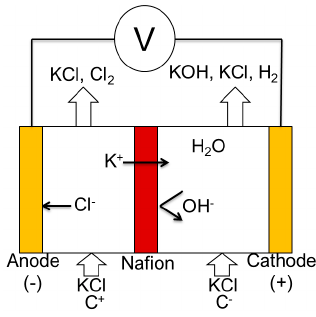
Figure 6. Ionic exchanges in the microfluidic neuron. C + corresponds to high concentration, C − to low concentration. The electrical potential form the anode and cathode mimics the action potential of one neuron. The Nafion membrane allows the flow of K + but reject the negative ion, like OH − .